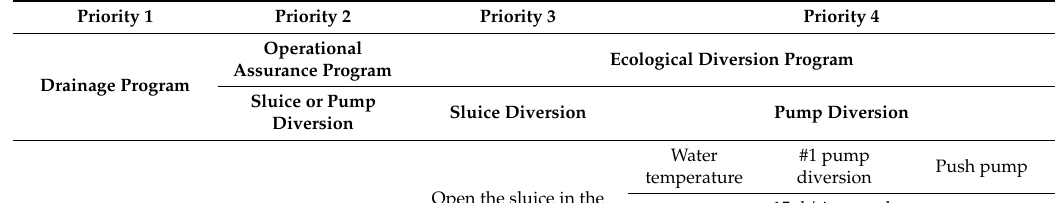
Table 9. Overall scheduling scheme